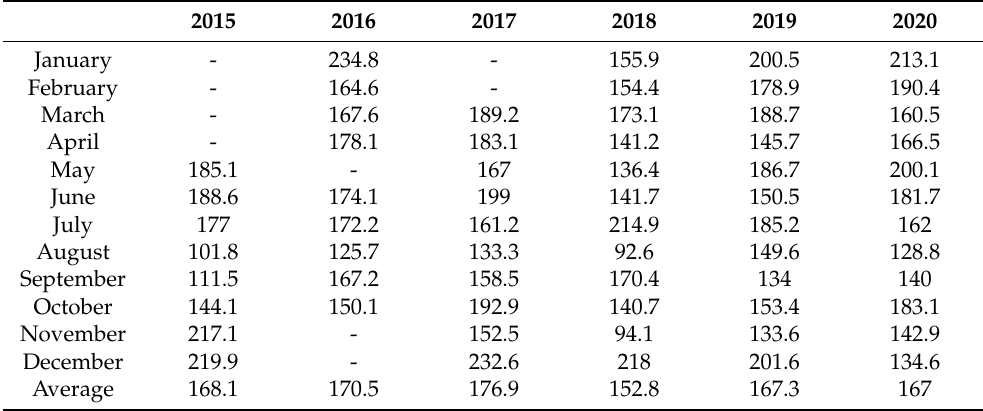
Table 3. Statistics for wind direction ( ◦